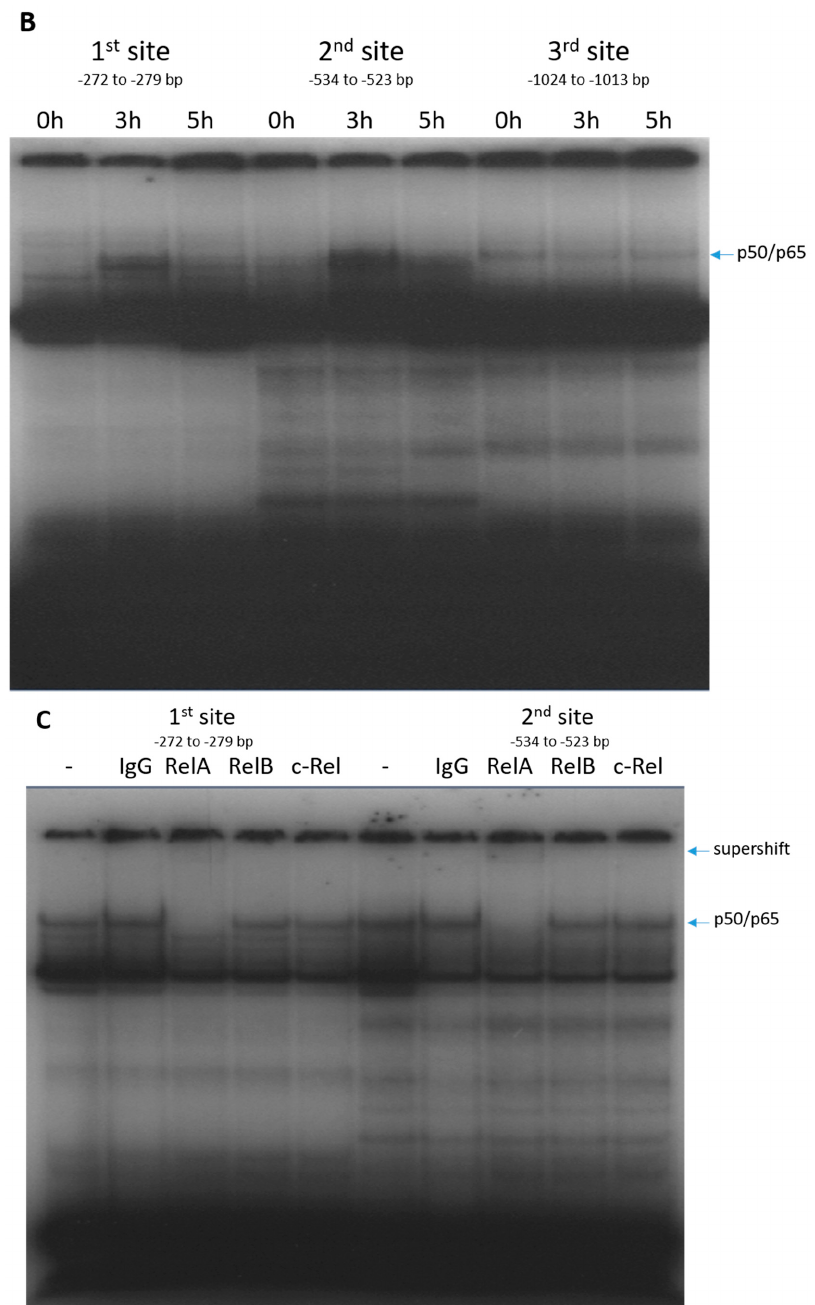
Figure 3. Binding of p50/RelA to putative NF- κ B binding sites of the CX3CL1 promoter. ( A ) By sequence analysis three recognition motifs for NF- κ B binding were identified in the CX3CL1 promoter. The consensus motif of the DNA sequences in these regions (written below) is underlined; ( B ) Panc1 cells were left untreated or treated with 10 ng/mL TRAIL for 3 h or 5 h, respectively. Nuclear extracts were submitted to EMSA with an oligonucleotide containing the potential NF- κ B binding site of the CX3CL1 promoter. One representative out of two independent experiments is shown; ( C ) Nuclear extracts from 3 h TRAIL treated Panc1 cells were analyzed in supershift experiments using the indicated antibodies and oligonucleotides containing the potential NF- κ B binding site of the CX3CL1 promoter. One representative out of two independent experiments is